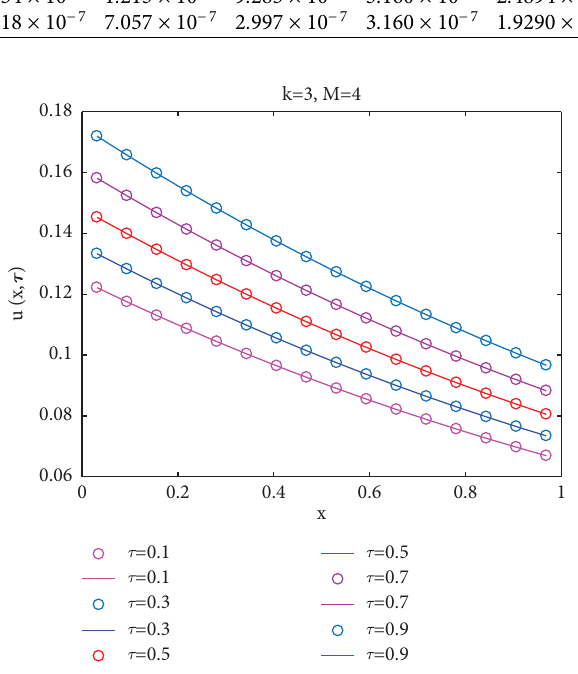
Figure 1: Approximate and exact solution for diferent τ of Example